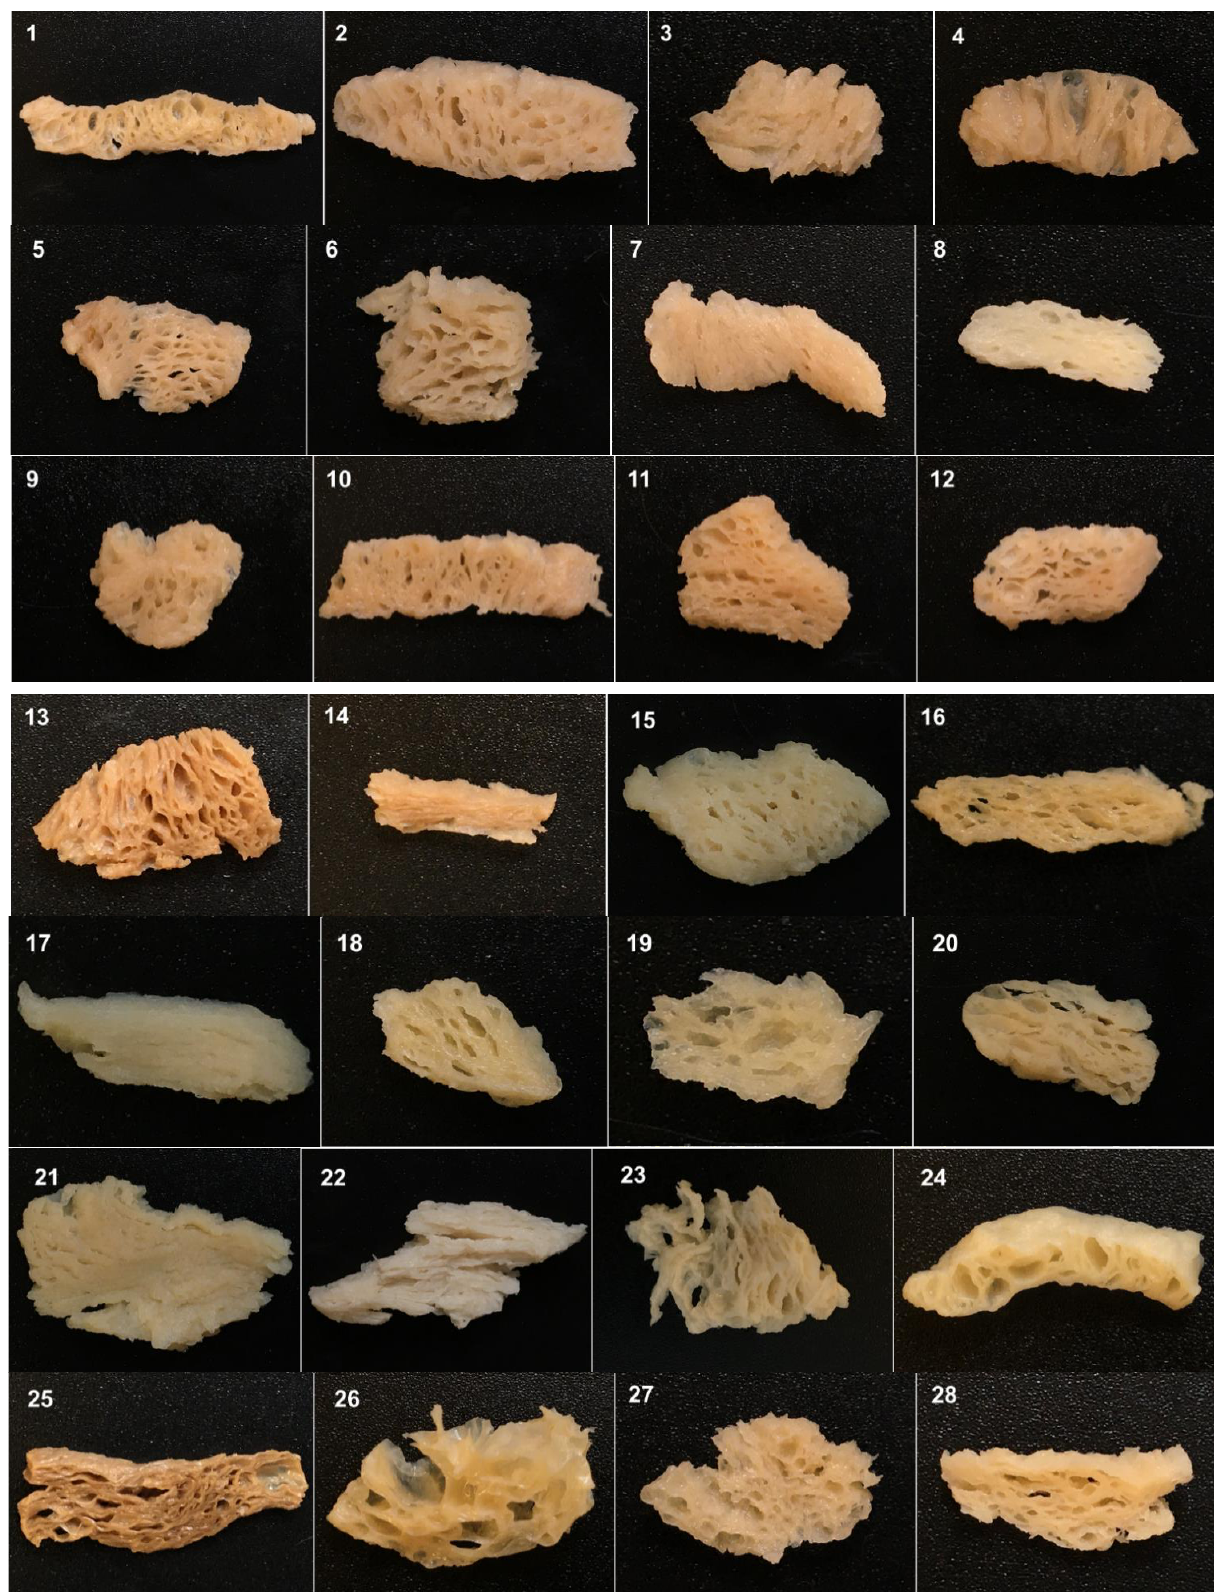
Figure 1. Visible appearance of different commercial TVPs. TVP types: 1 – 14: textured soy proteins; 15 – 21: textured pea proteins; 22 – 25: textured wheat gluten; 26: textured chickpea protein; 27: tex- tured pea/chickpea mixed proteins; 28: textured pea/navy bean mixed proteins.